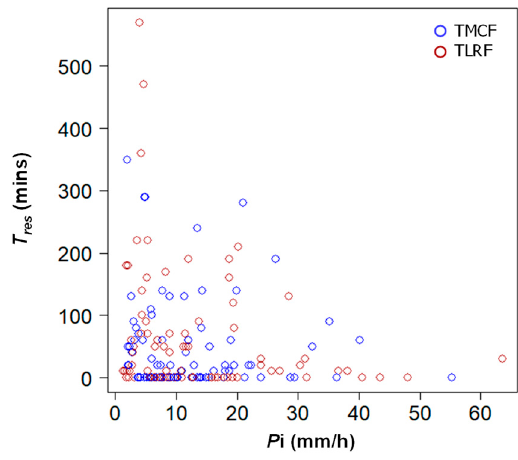
Figure 5. T res versus P i.